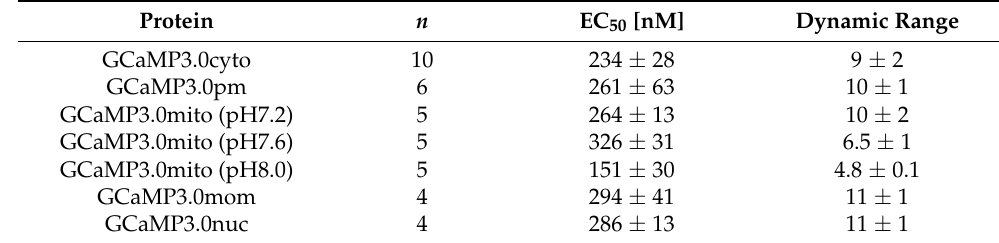
Figure 2. In vitro characterization of GCaMP3.0nuc. The construct was cloned into pRSET A vector, over-expressed in E. coli (BL21(DE3)LysS cells and affinity purified via Ni-NTA agarose. Purified GCaMP3.0nuc protein (2 µ M final concentration) was diluted in incubation buffer (30 mM MOPS, 100 mM KCl, pH 7.2) adjusted to the desired [Ca 2+ ] free with CaEGTA (10 mM)/K 2 EGTA (10 mM). ( A ) For each [Ca 2+ ] free the fluorescence emission spectrum of GCaMP3.0nuc was registered upon excitation at 470 nm. Spectra obtained at 0 µ M and 39.0 µ M [Ca 2+ ] free are indicated with arrows. Maximal fluorescence intensity was detected at 510 nm. ( B ) Fluorescence intensity at 510 nm was plotted against log [Ca 2+ ] free . The Ca 2+ -concentration–response curve was calculated with GraphPad Prism (5.04). Data represent the values from a typical experiment. Experiments were independently repeated at least four times for each construct (see Table 1). Table 1. Mean values for half-maximal stimulation (EC 50 [nM]) and dynamic range of GCaMP3.0 variants by [Ca 2+ ] free . Values were obtained from non-linear fitting of the data ( n = number of experiments) from concentration–response curves (GraphPad Prism